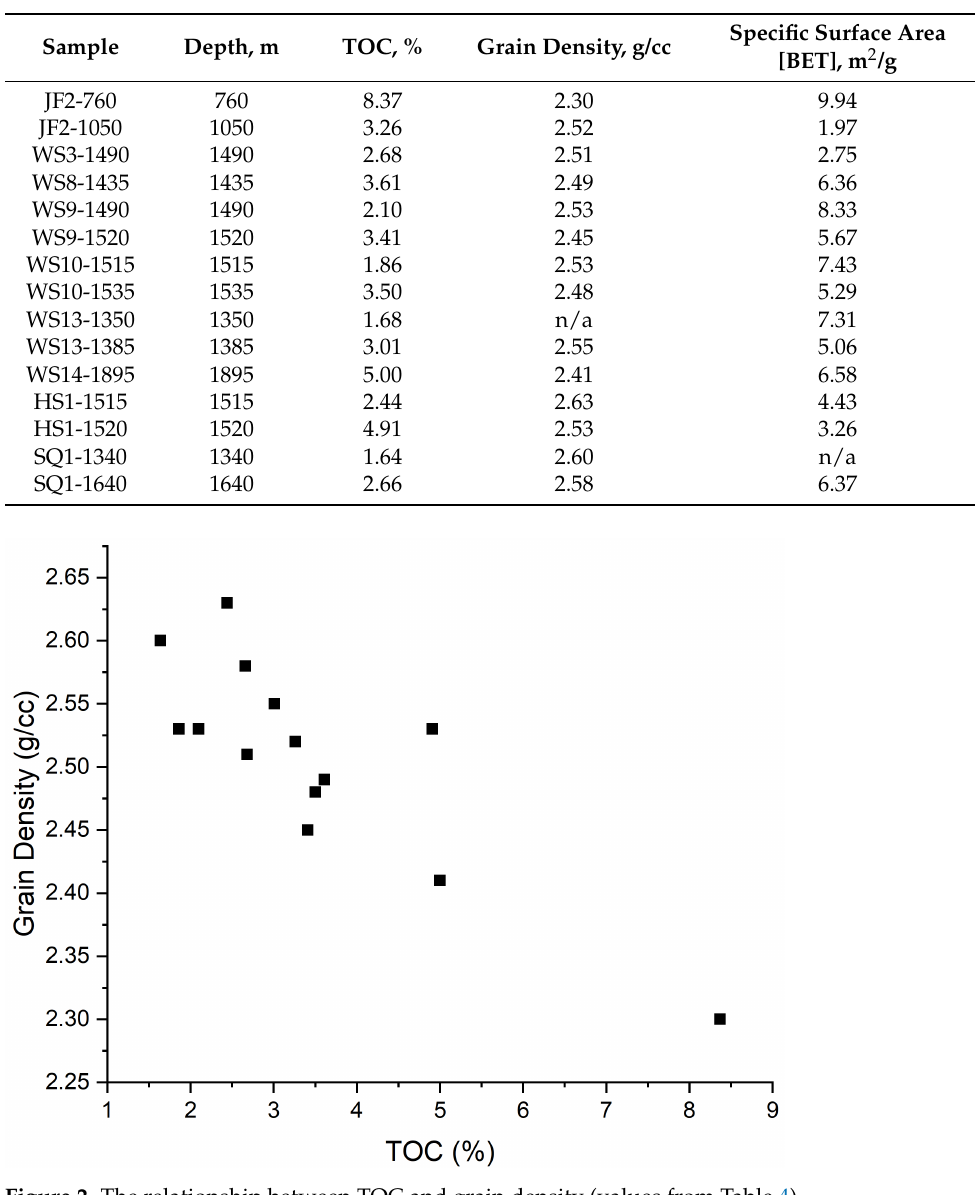
Figure 2. The relationship between TOC and grain density (values from Table 4). Specific surface area determination represents a very useful method regarding porous media characterization. Gas adsorption is the appropriate and most used method to solve this task. The BET (Brunauer, Emmett, and Teller) theory is commonly used to evaluate the gas adsorption data and generate a specific surface area result. One of the most important BET analyses and assumptions is that adsorption occurs by multilayer formation and that the number of adsorbed layers is infinite at the saturation pressure, i.e., adsorption occurs as if on a free surface. As the TOC increases, the SSA values are expected to increase. The SSA of these samples using the Brunauer Emmette Teller (BET) models is listed in Table 4. The SSA (BET) of these samples is in the range of 1.97–9.94%. The SSA (BET) has a positive correlation with the TOC value (Figure